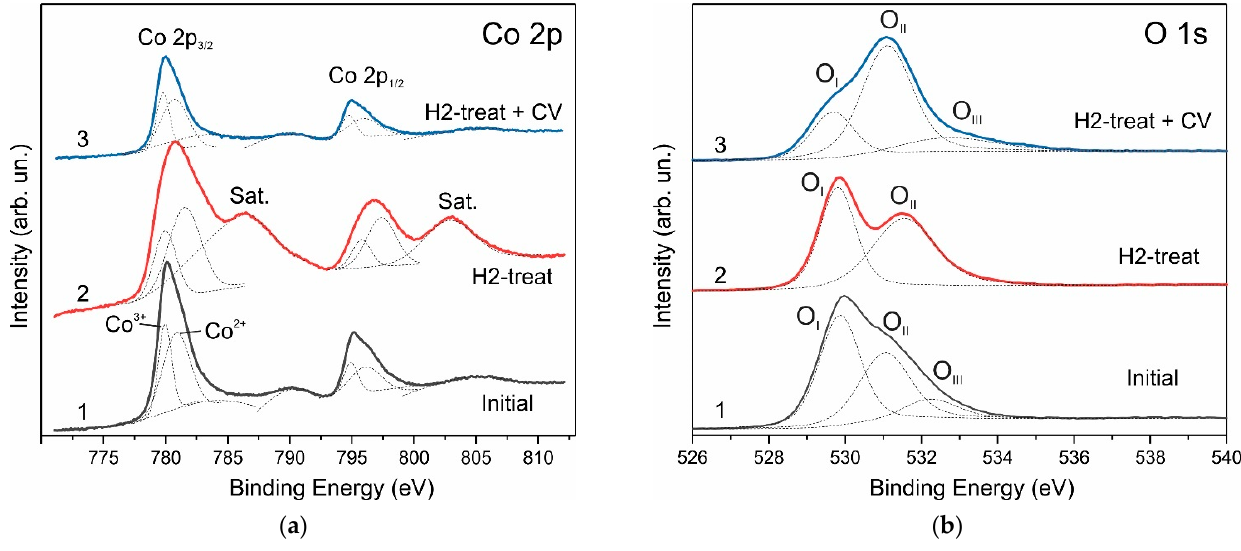
Figure 9. High-resolution Co 2p ( a ) and O 1s ( b ) XPS spectra for the Co 3 O 4 NPs–NF electrode: 1— spectrum of pristine electrode before H2-treatment; 2—spectrum after H2-treatment, and 3—after H2-treatment followed by CV measurement. The dotted lines demonstrate the decomposition of the spectra into individual components.